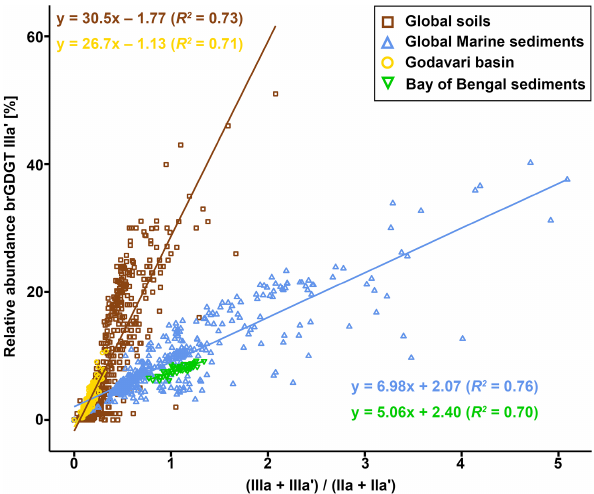
Figure 9. Cross plot of the ratio (IIIa + IIIa (cid:48) ) / (IIa + IIa (cid:48) ) versus the relative abundance of IIIa (cid:48) for globally distributed soils (square) and marine sediments (triangle) after Xiao et al. (2020) and Go- davari basin samples, including soils, SPM, and riverbed sediments collected the dry and wet seasons (circle) and the Bay of Bengal Holocene sediments (inverted triangle). The solid lines denote the linear fit, and the correlations and R 2 are